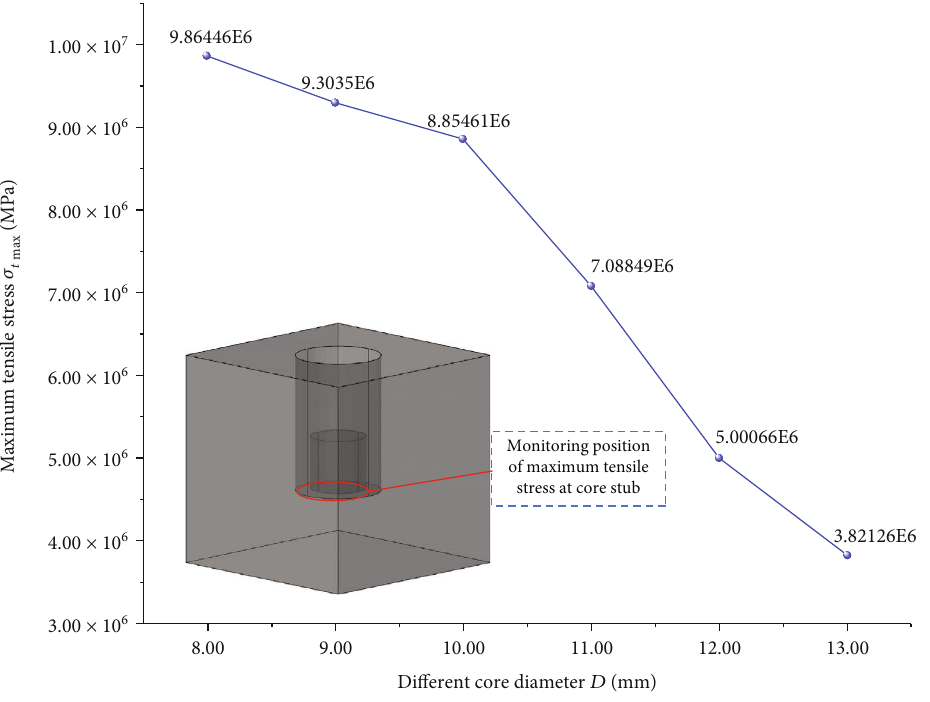
Figure 6: Variation of the maximum tensile stress σ